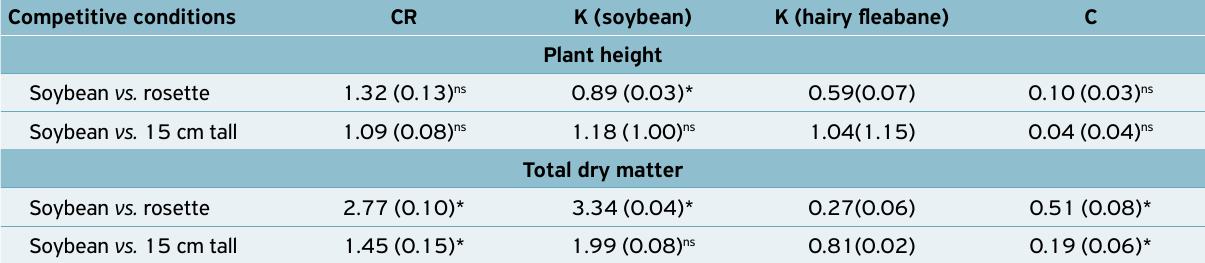
Table 4. Competitiveness indices of soybean and hairy fleabane of different growth stages (rosette and 15 cm tall), expressed by their relative competitiveness index (RC), coefficients of relative clustering (K) and competitiveness (C).